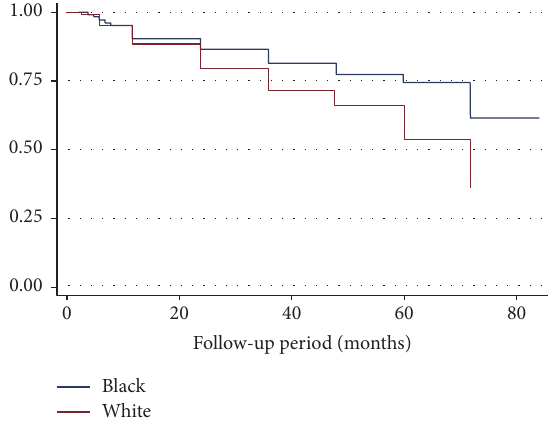
Figure2:KaplanMeiersurvivalcurvebetweenblackandwhite( 𝑃 = 0.004 ).